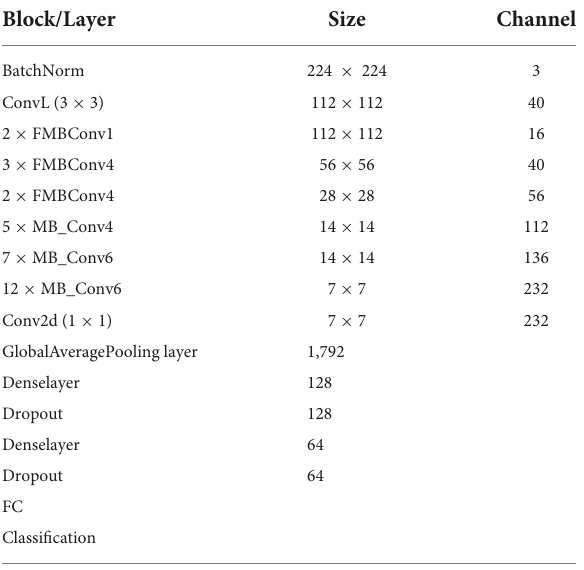
TABLE 1 Architectural details of the proposed framework.